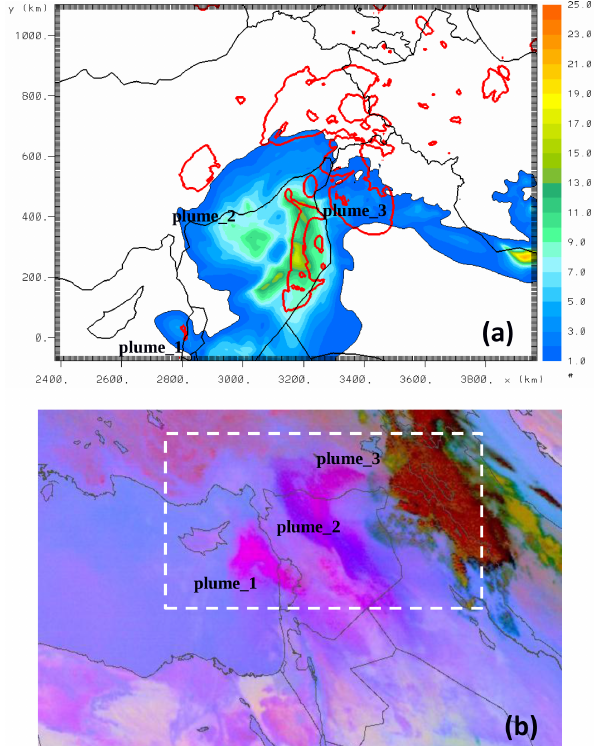
Figure 5. (a) Model AOT at 550nm (colour scale) and cloud cover > 70% (red contour). (b) MSG-SEVIRI dust RGB component on 7 September 2015, 00:00UTC. The white rectangle approximately indicates the location of the model domain shown in (a) .